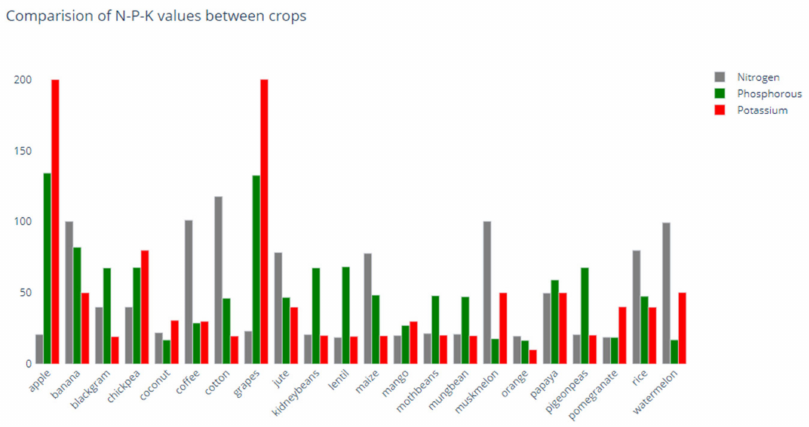
Figure 8. Comparison of N, P, K requirements of different